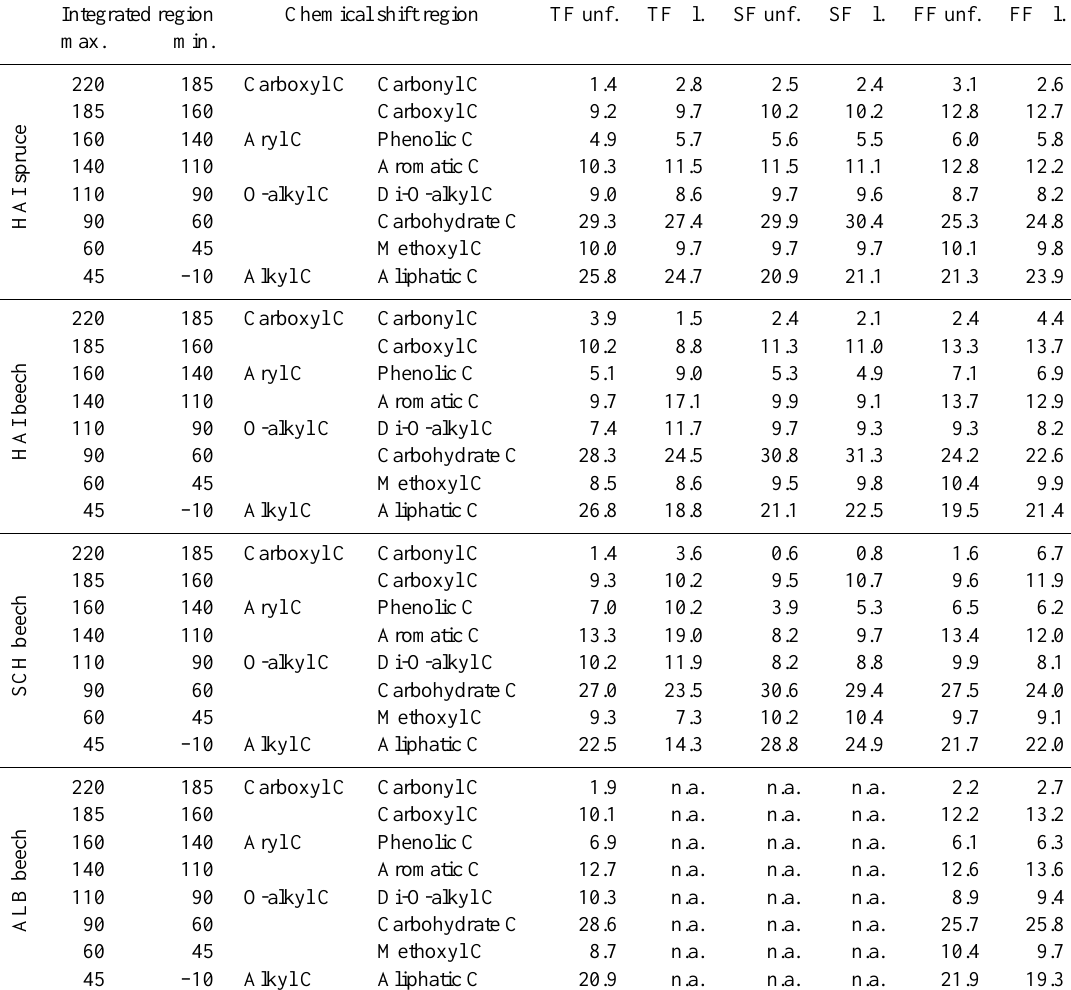
Table 3. Relative signal intensity (in %) of chemical shift regions revealed by solid-state 13 C NMR spectroscopy (filtered (fil.) and unfiltered (unf.) samples of throughfall (TF), stemflow (SF) and forest floor (FF) leachates; n.a. – not analysed; ALB – Schwäbische Alb; HAI – Hainich–Dün; SCH – Schorfheide–Chorin). Integrated region Chemical shift region TF unf. TF fil. FF